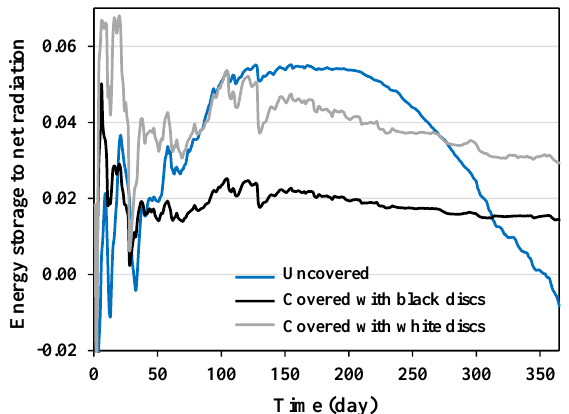
Figure 11. Model estimates of changes in the ratio of energy storage in the water body to the net radiative flux at the surface of uncovered and partially covered hypothetical 10m deep reservoirs (Majadas, Spain). The heat storage is calculated relative to the reference state at the beginning of the water year. Following an equilibration pe- riod, the ratio follows the annual variations in the radiative flux for the uncovered reservoir, whereas for the partially covered surface, the ratio remains nearly